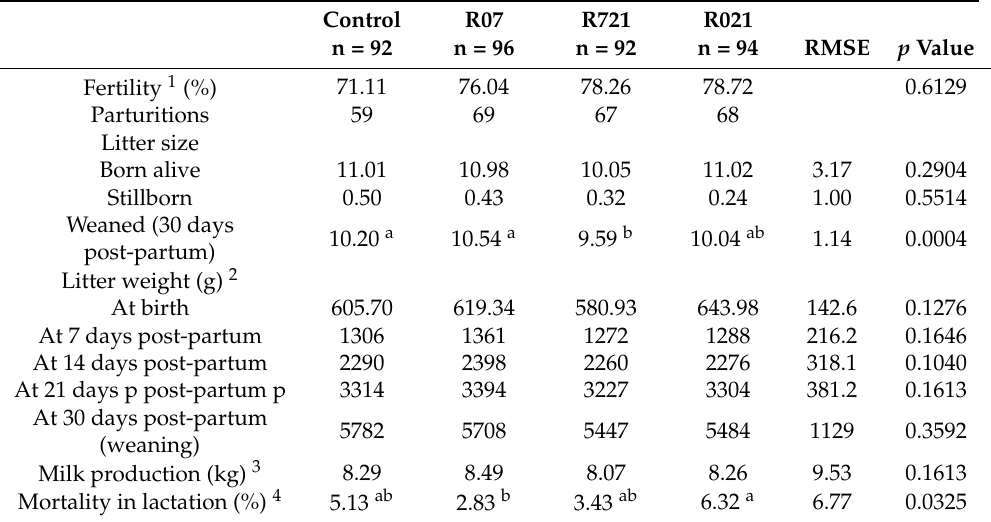
1 Number of does pregnant after pregnancy diagnosis at 11 days post AI/total does inseminated × 100. 2